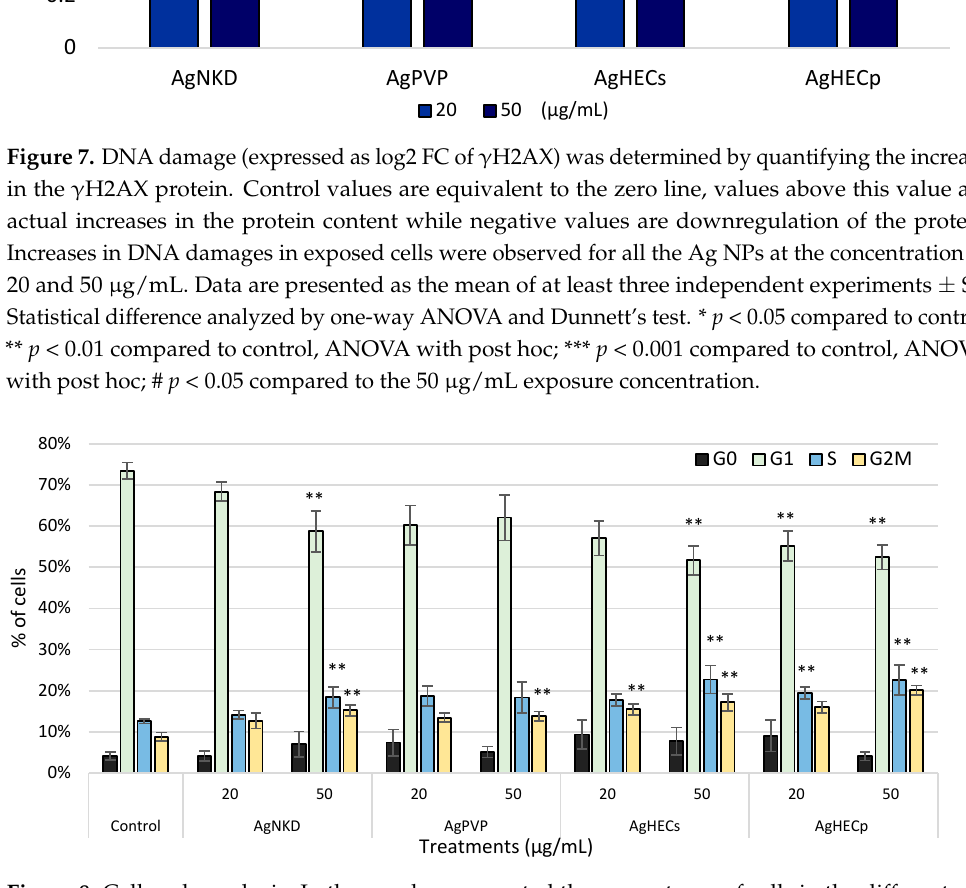
Figure 8. Cell cycle analysis. In the graph are reported the percentages of cells in the different cell cycle phases: subG0, G1, S and G2M (n > 3). It is possible to observe a statistically significant increase in cells in G2M phase after treatment with all the Ag NPs. Data are presented as the mean of at least three independent experiments ± SE. Statistical analysis: one-way ANOVA followed by Dunnett’s test; ** p -value = 0,01 compared to control.